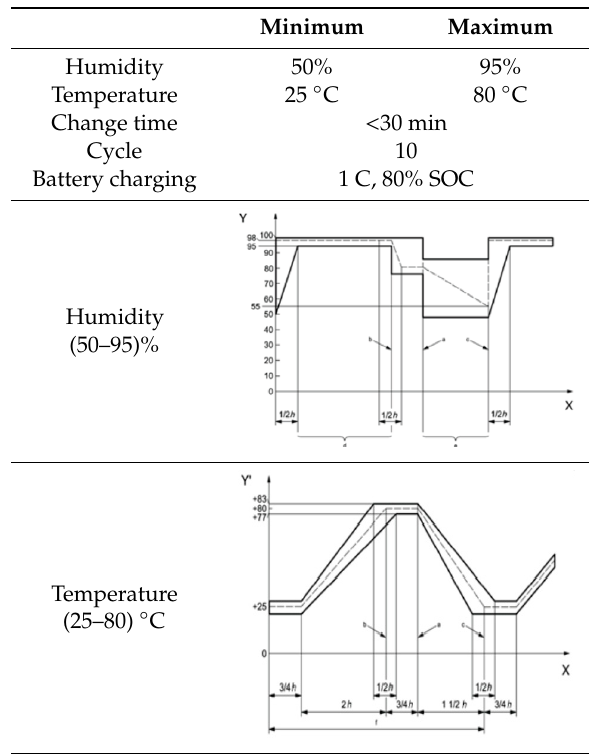
Table 6. Test profile for dewing of Lithium-ion battery.